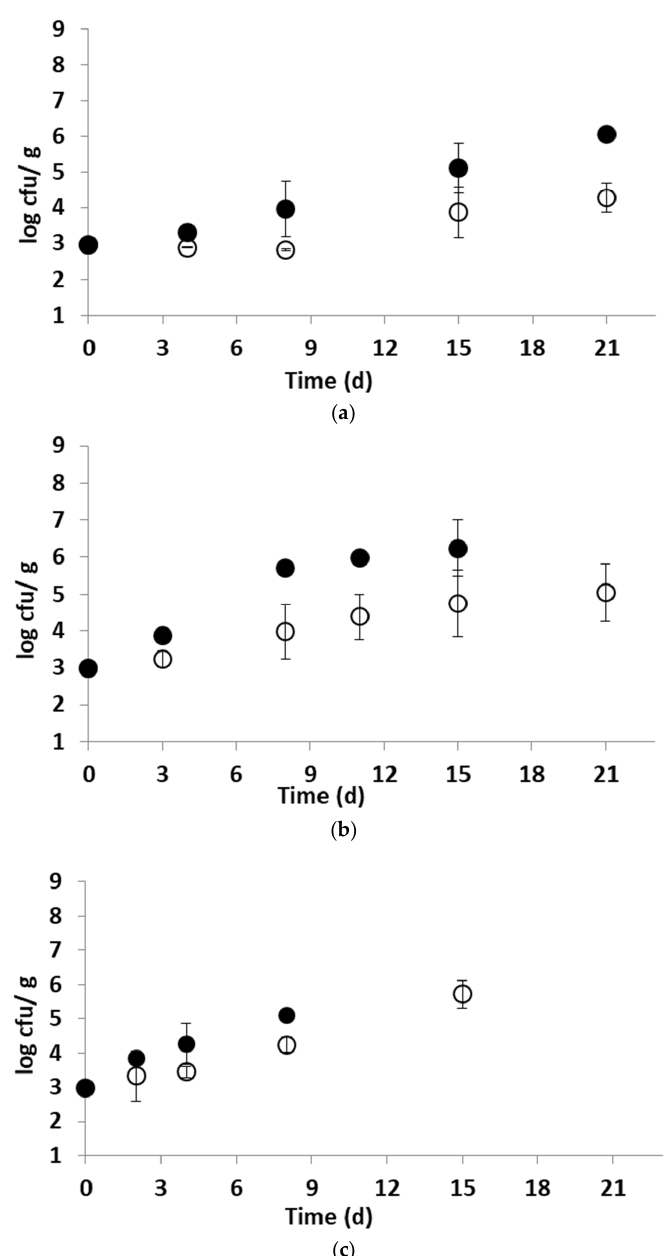
Figure 4. Pseudomonas spp. count in MAP and ACT-MAP sea bass during the isothermal storage at ( a ) 0 ◦ C, ( b ) 5 ◦ C, and ( c ) 10 ◦ C ( ACT-MAP, (cid:8) (cid:35)